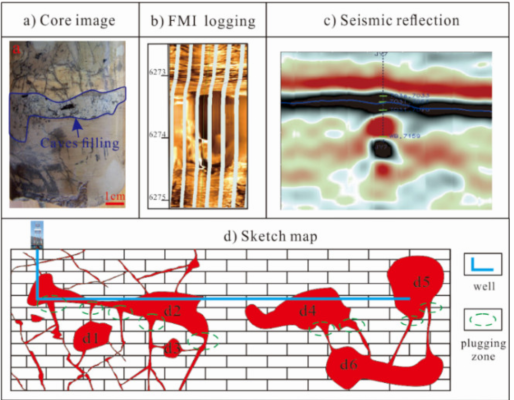
Figure 1. The characteristics of fractured-vuggy carbonate reservoir spaces. ( a ) The caves filling in the core. ( b ) The characteristic of cave on FMI logging. ( c ) The characteristic of cave on seismic reflection. ( d ) The sketch map in cave reservoir during horizontal well drilling, the proper lugging zones are shown as green dashed line. d1 Cave with throats in the upper and lower parts, with no throat in the horizontal direction; d2 A higher-coordinating structure, for which there are many throats around the cave; d3 Cave with throats in the landscape direction, but no throats in portrait direction; d4~d5 Upper cave and lower throat type;d6 Lower cave and upper throat